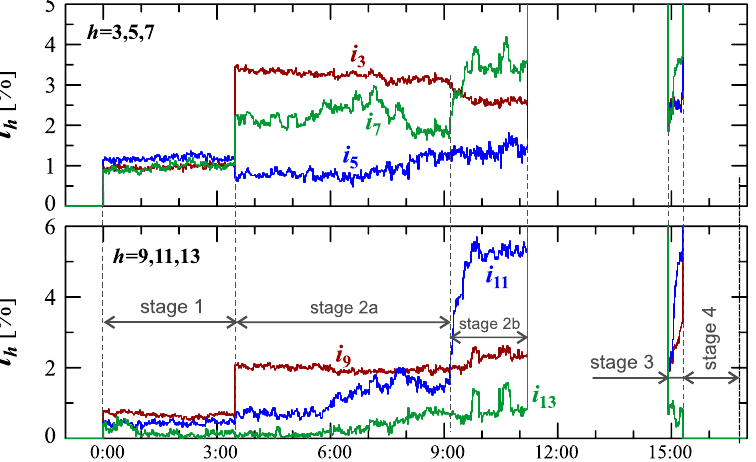
Figure 28. The characteristics of odd harmonics of the current i h = f ( t ) from the order h = 3 to 13 for Case